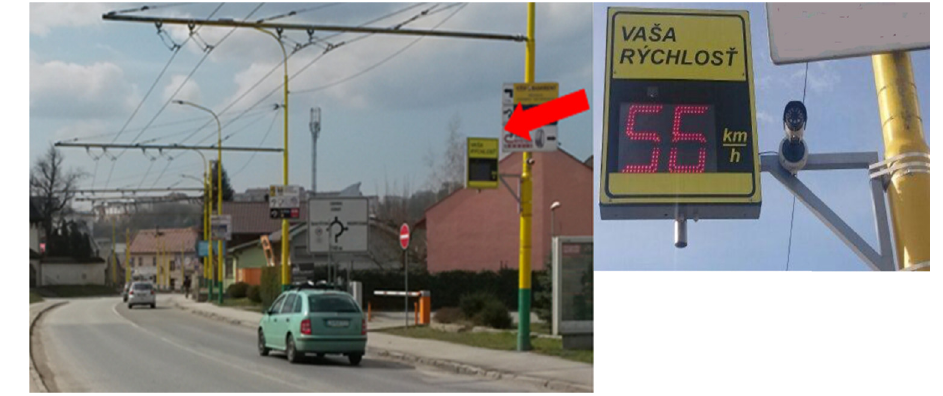
Figure 1: The speedometer and its